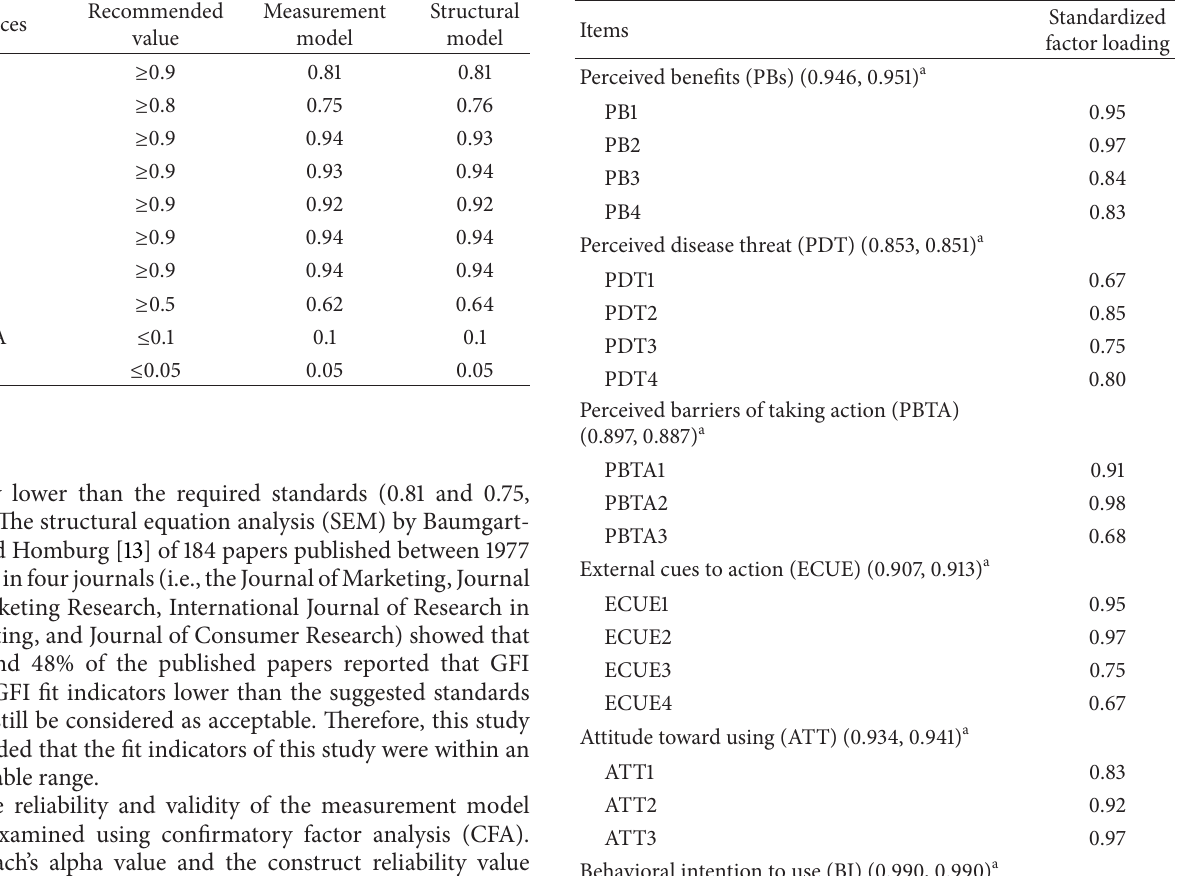
Table 2: Fit indices for measurement and structural model. Table 3: Reliability and validity results. Items